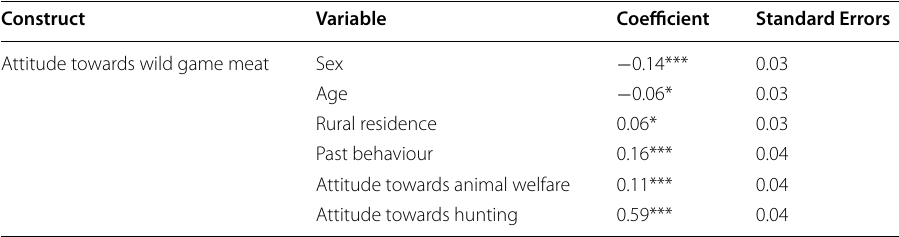
*indicates a significance of 90%, **of 95% and ***of 99%